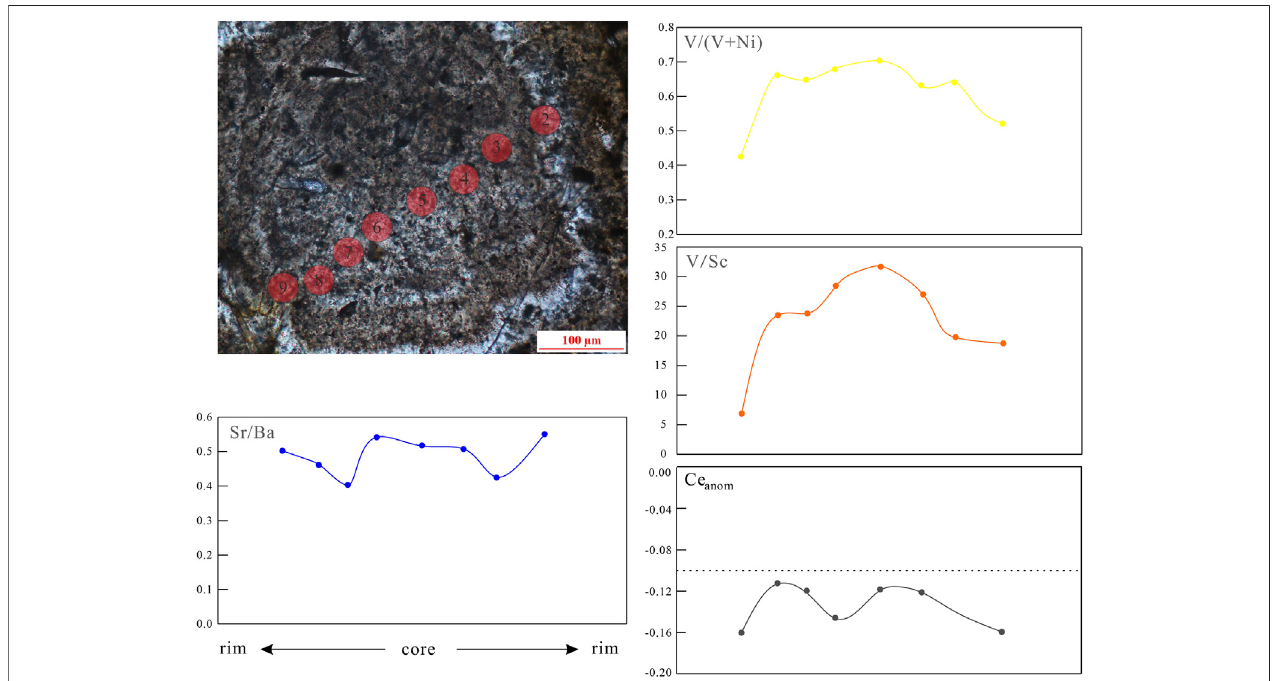
FIGURE 11 | Variation curves from center to edge of concentric